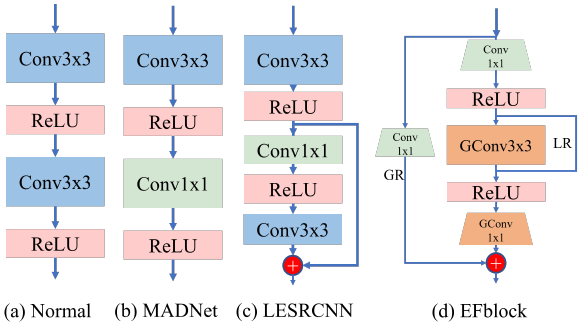
Figure 2. Feature extraction blocks used in several recent SR